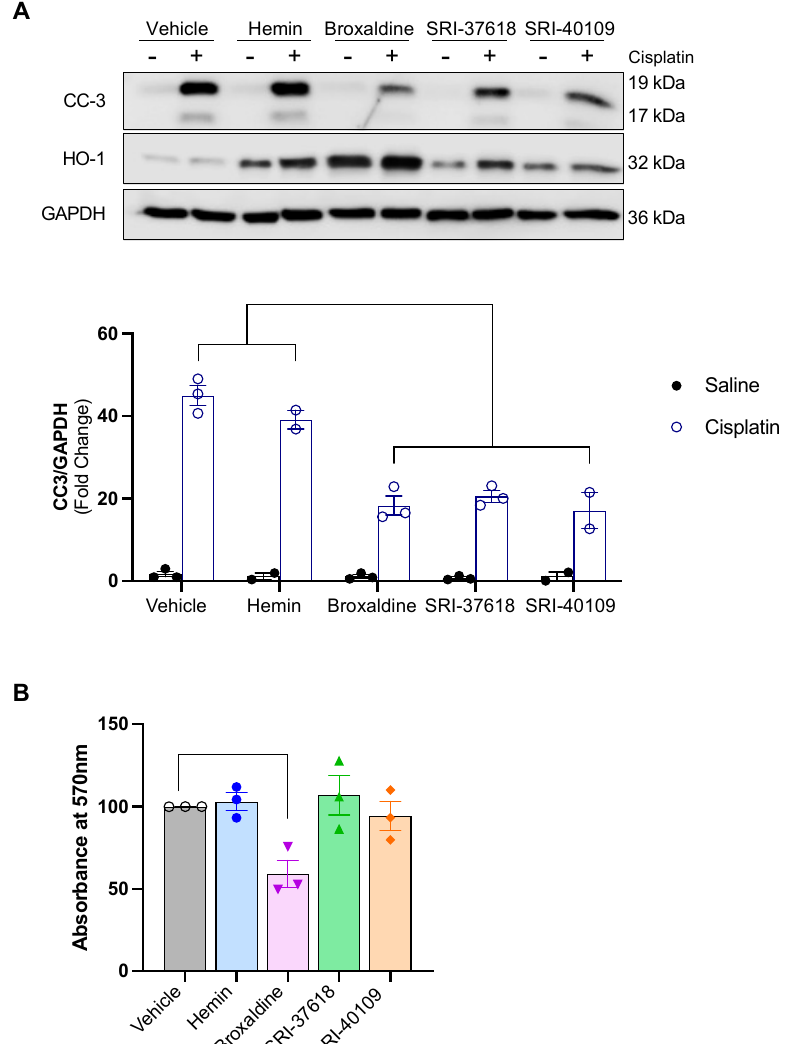
Figure 7. ( A ) Western blot for cleaved caspase-3 (CC-3) and heme oxygenase-1 (HO-1) in HEK293 cells pretreated with listed compounds or controls for 8 h prior to cisplatin exposure. ( B ) MTT assay of HEK293 cells treated with compounds or vehicle control. Absorbance at 570 nm relative to vehicle control reflects the conversion of MTT (3-(4,5-dimethylthiazolyl-2)-2, 5-diphenyltetrazolium bromide) into formazan and is used as an indirect proxy for relative cell viability. Data analyzed by one-way ANOVA followed by Dunnett’s test for multiple